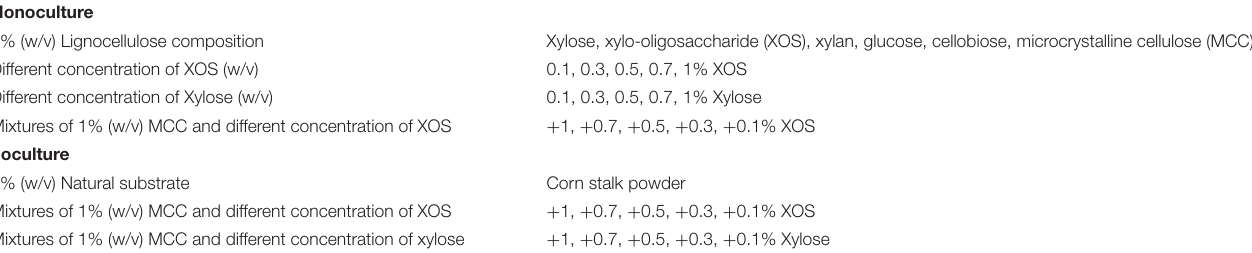
TABLE 1 | List of the carbon sources used in this study for respective monoculture and coculture of Thermomyces lanuginosus and Thermobifida fusca in liquid-state medium.